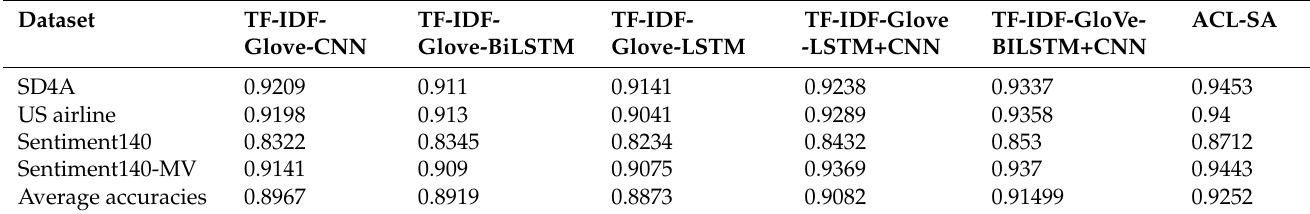
Table 7. Summary of the proposed model’s accuracy.